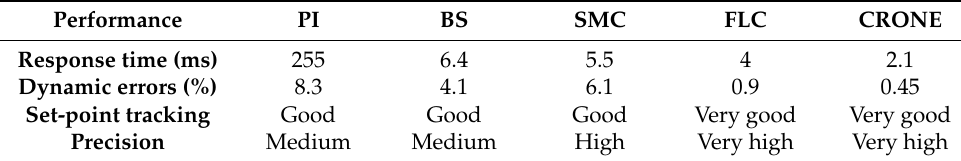
Figure 20. Speed error for PI, BS, SMC, FLC, and CRONE controllers. Table 4. Comparative study for the real wind speed of Essaouira city,